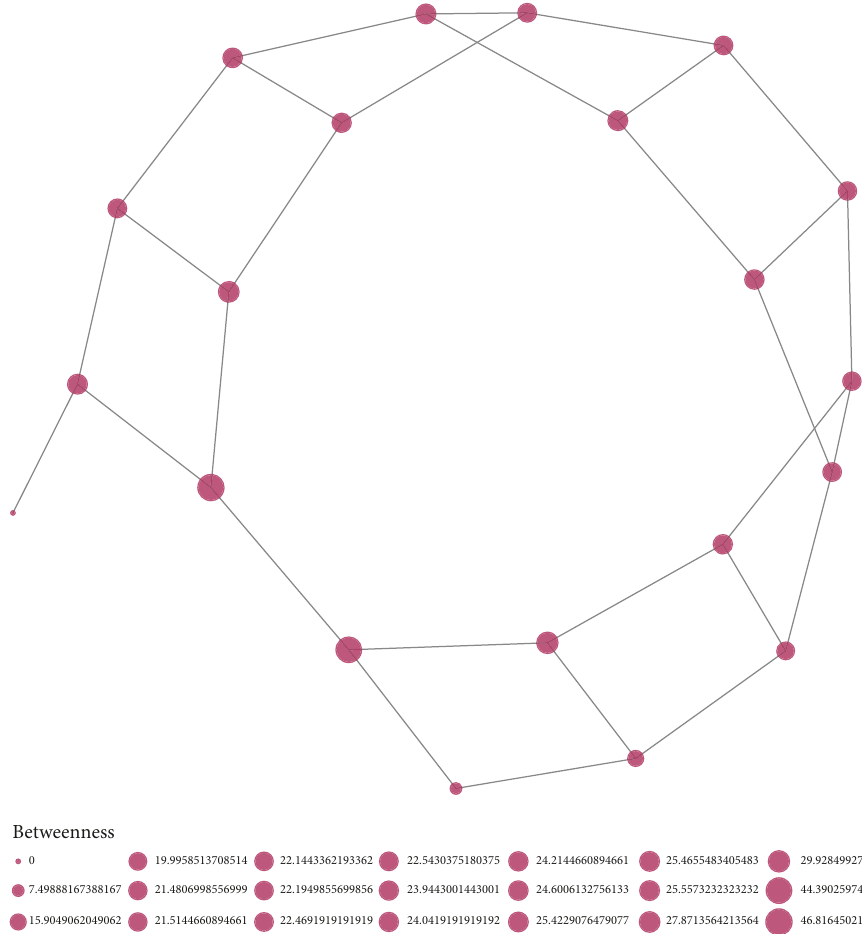
Figure 6: Ouroboros